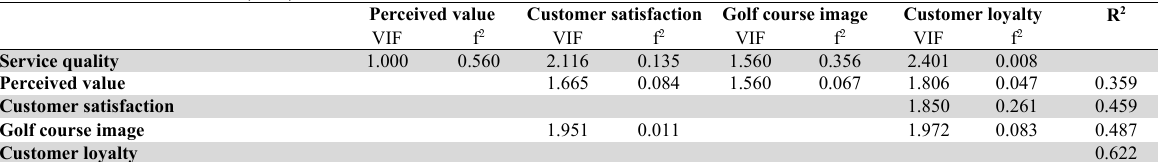
Variance inflation factors (VIF), effect size f 2 , and R 2 values of constructs in the model